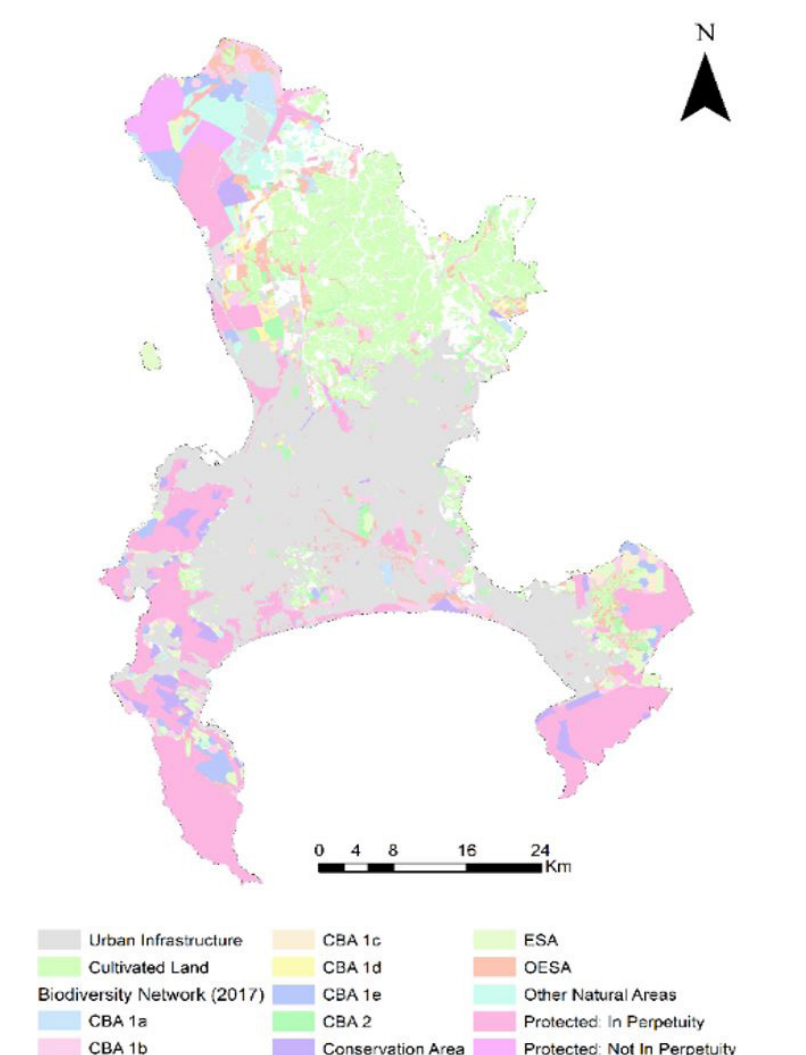
Figure 2. The city of Cape Town municipal boundary showing urban infrastructure, cultivated land and the City’s Biodiversity